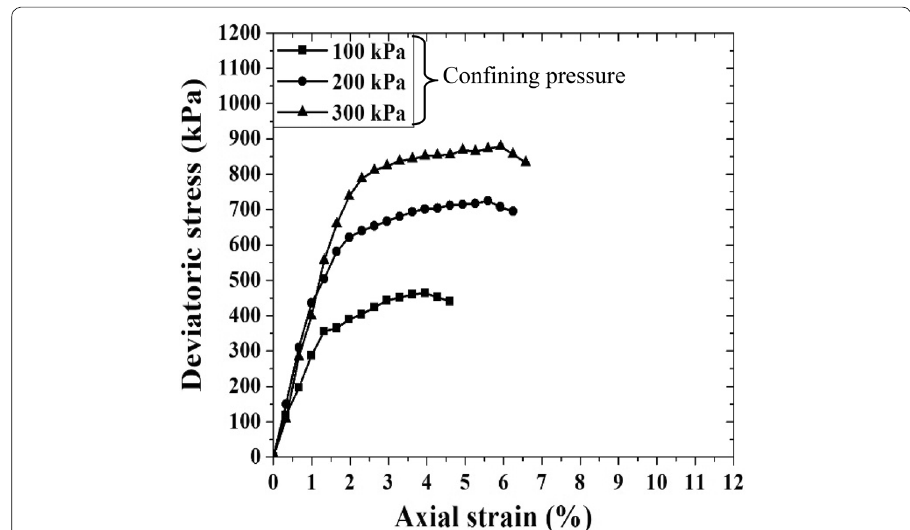
Fig. 24 Stress strain behavior of KTPS bottom ash at RC-98%